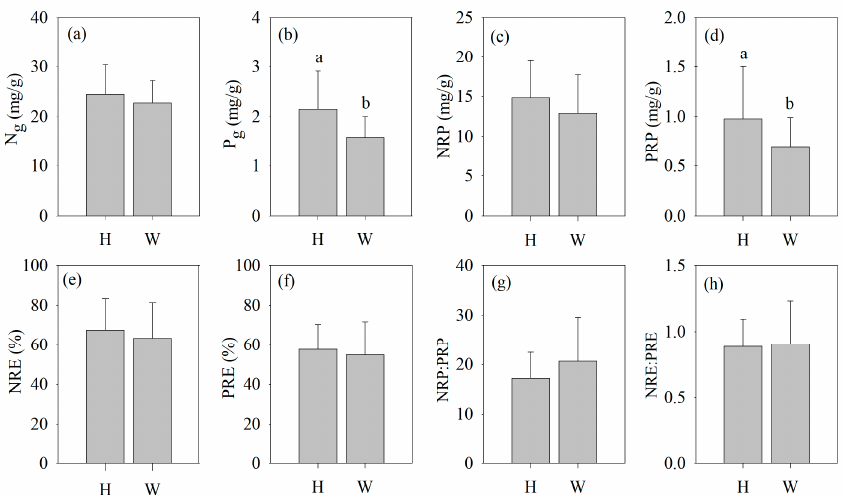
Figure 1. Leaf N and P nutrient traits and resorption traits of two plant growth forms (PGFs). ( a ) N g (N content of green leaves) of H (herbaceous species) and W (woody species). ( b ) P g (P content of green leaves) of H and W. ( c ) NRP (N resorption proficiency) of H and W. ( d ) PRP (P resorption proficiency) of H and W. ( e ) NRE (N resorption efficiency) of H and W. ( f ) PRE (P resorption efficiency) of H and W. ( g ) NRP:PRP of H and W. ( h ) NRE:PRE of H and W. The mean values of all traits are compared between two PGFs, using a nonparametric multiple test procedure. Different lowercase letters (a and b) mean significant difference ( p <